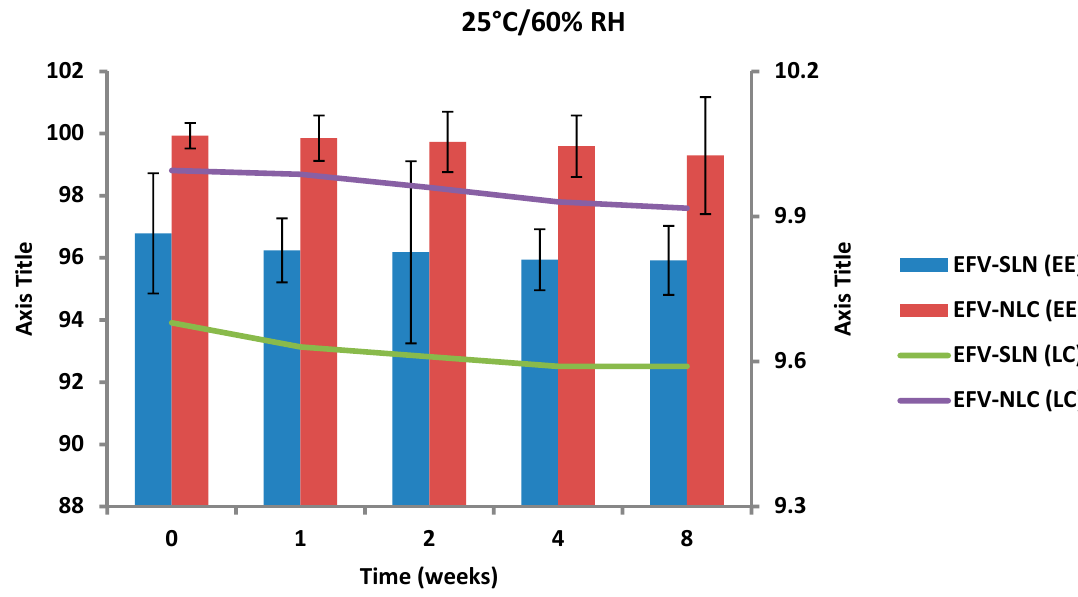
Figure 17. Encapsulation efficiency and loading capacity of SLN and NLC following storage at 25 °C/60% RH .